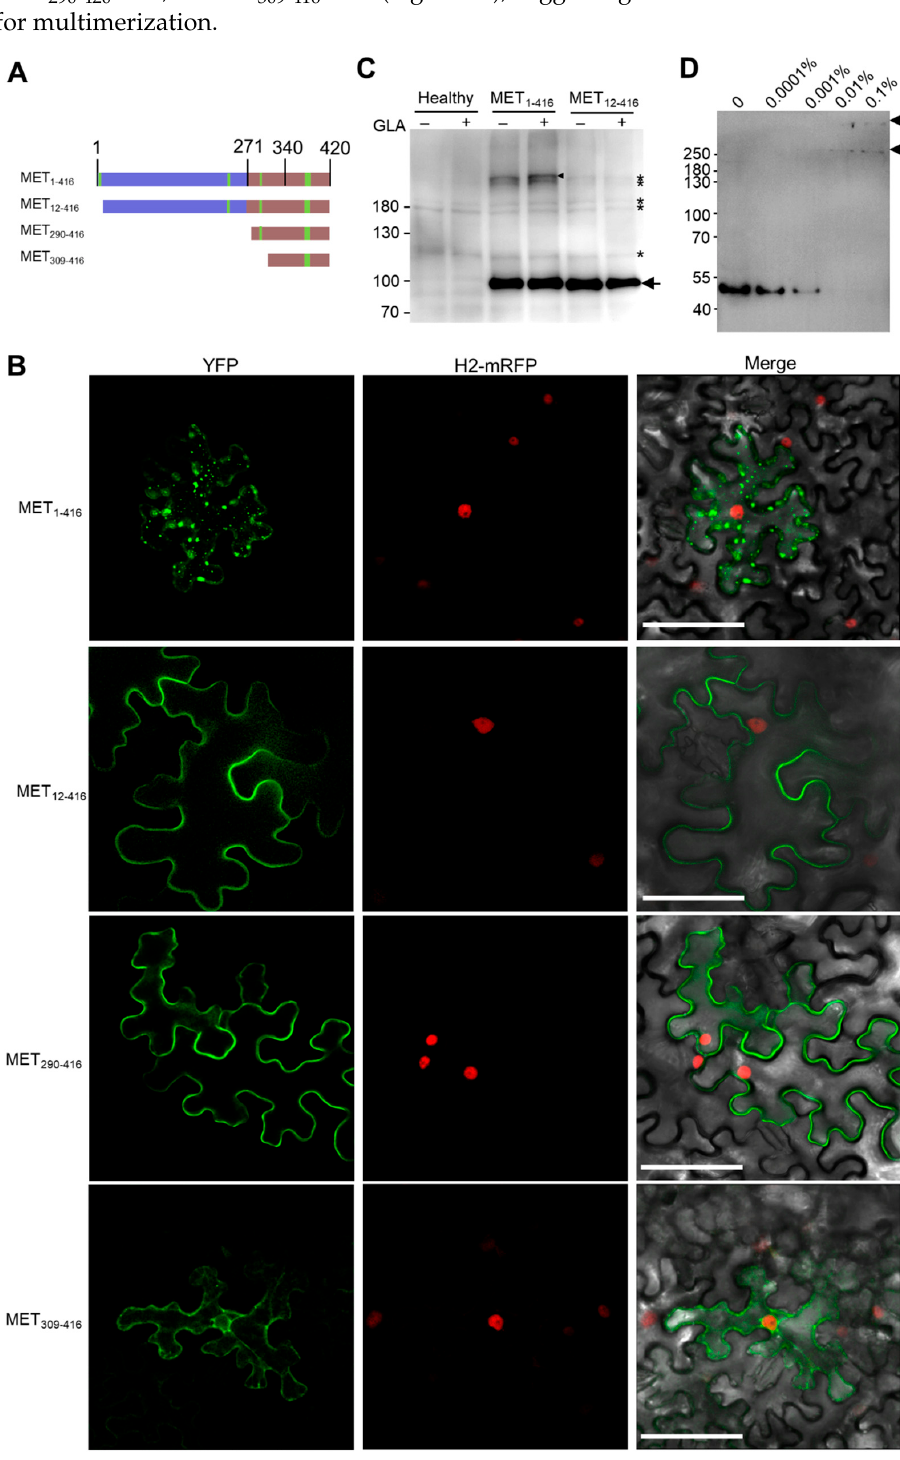
Figure 5. MET domain of PVX RdRp forms multimers. ( A ) Illustration of MET1-416 mutants. The four putative membrane-association motifs are highlighted in yellow. ( B ) Confocal microscopic photos of N. benthamiana epidermal cells expressing MET 1-416 -YFP, MET 12-416 -YFP, MET 290-416 -YFP, and MET 309-416 -YFP at 2 dpi. ( C ) Western blotting analyses of MET 1-416 -YFP and MET 12-416 -YFP after glutaraldehyde treatment. ( D ) Western blotting analyses of purified 10×His-MET 1-416 that was treated by different concentrations of glutaraldehyde.